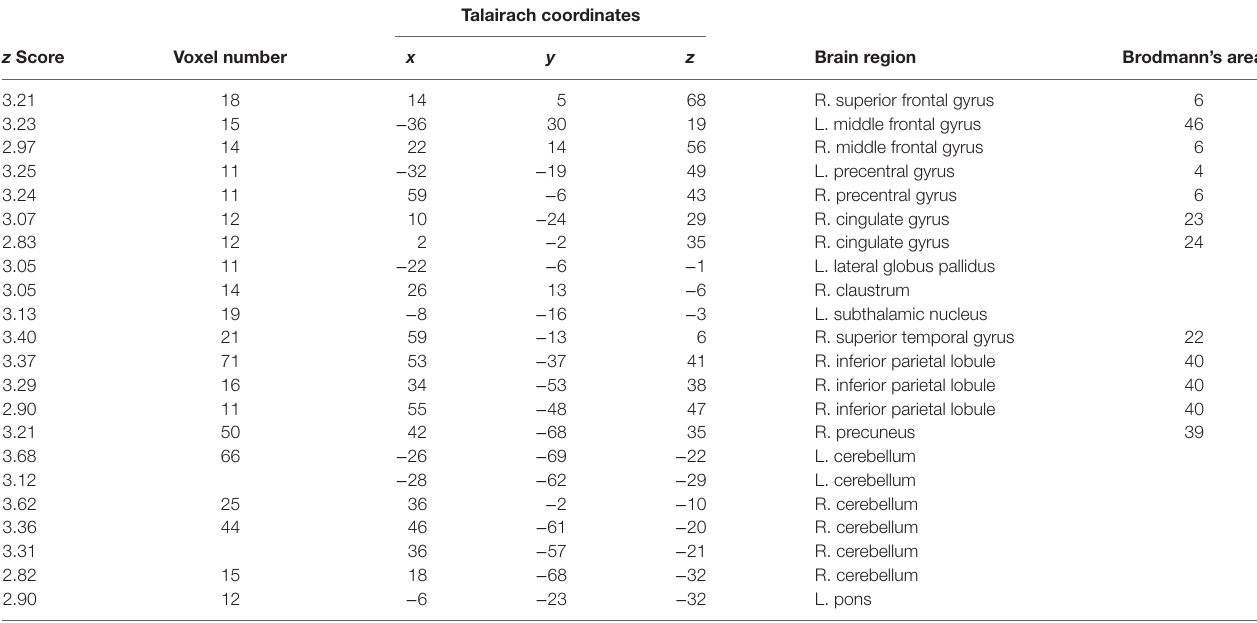
TaBle 7 | Areas of increased activation for traumatic slides and sounds in mindfulness-based stress reduction greater than present-centered group therapy.